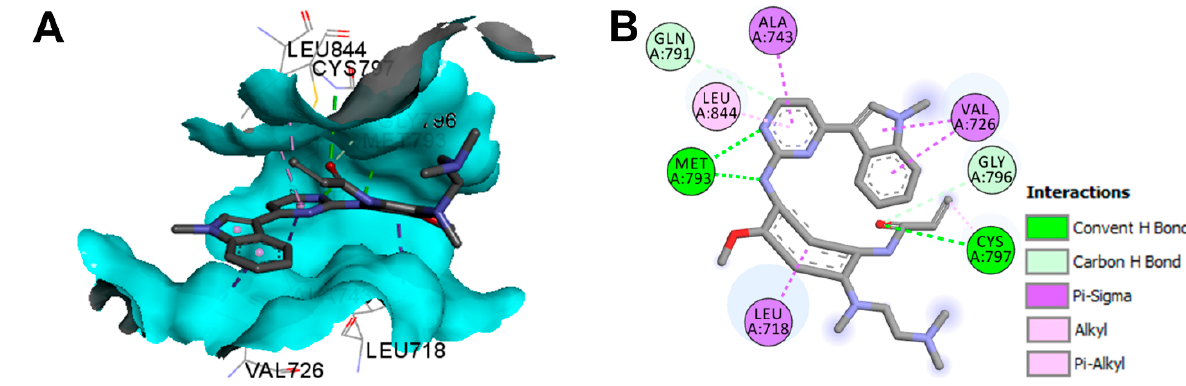
Figure 53 . Binding modes of osimertinib (shown as sticks) into the wild-type EGFR kinase (pdb: 4ZAU): ( A ) 3D binding mode, receptor shown as hydrogen bond surface; ( B ) 2D binding mode showing different types of binding interactions; the figure was generated using Discovery Studio Visualizer (V16.1.0.15350).